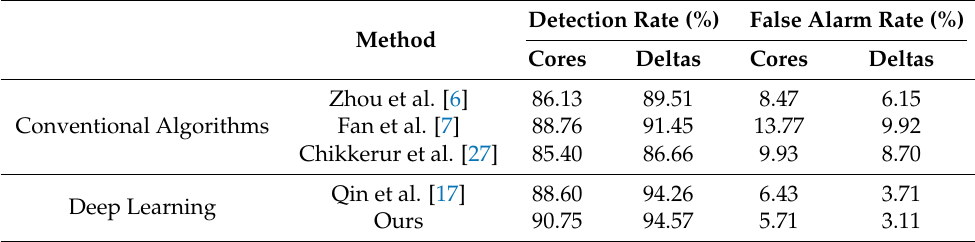
Table 2. The performance comparisons with different algorithms on NIST sd04